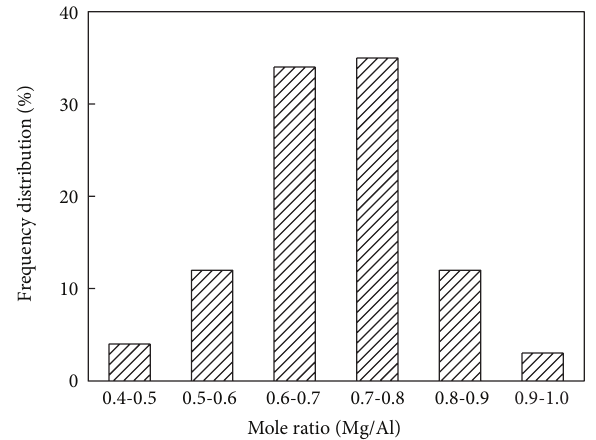
Figure 2: The distribution of central mole ratio (Mg/Al) for magnesia-bearing